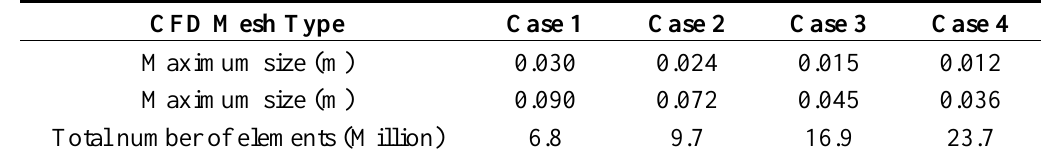
Table 1. The number of elements depending on the mesh size of wind turbine blade